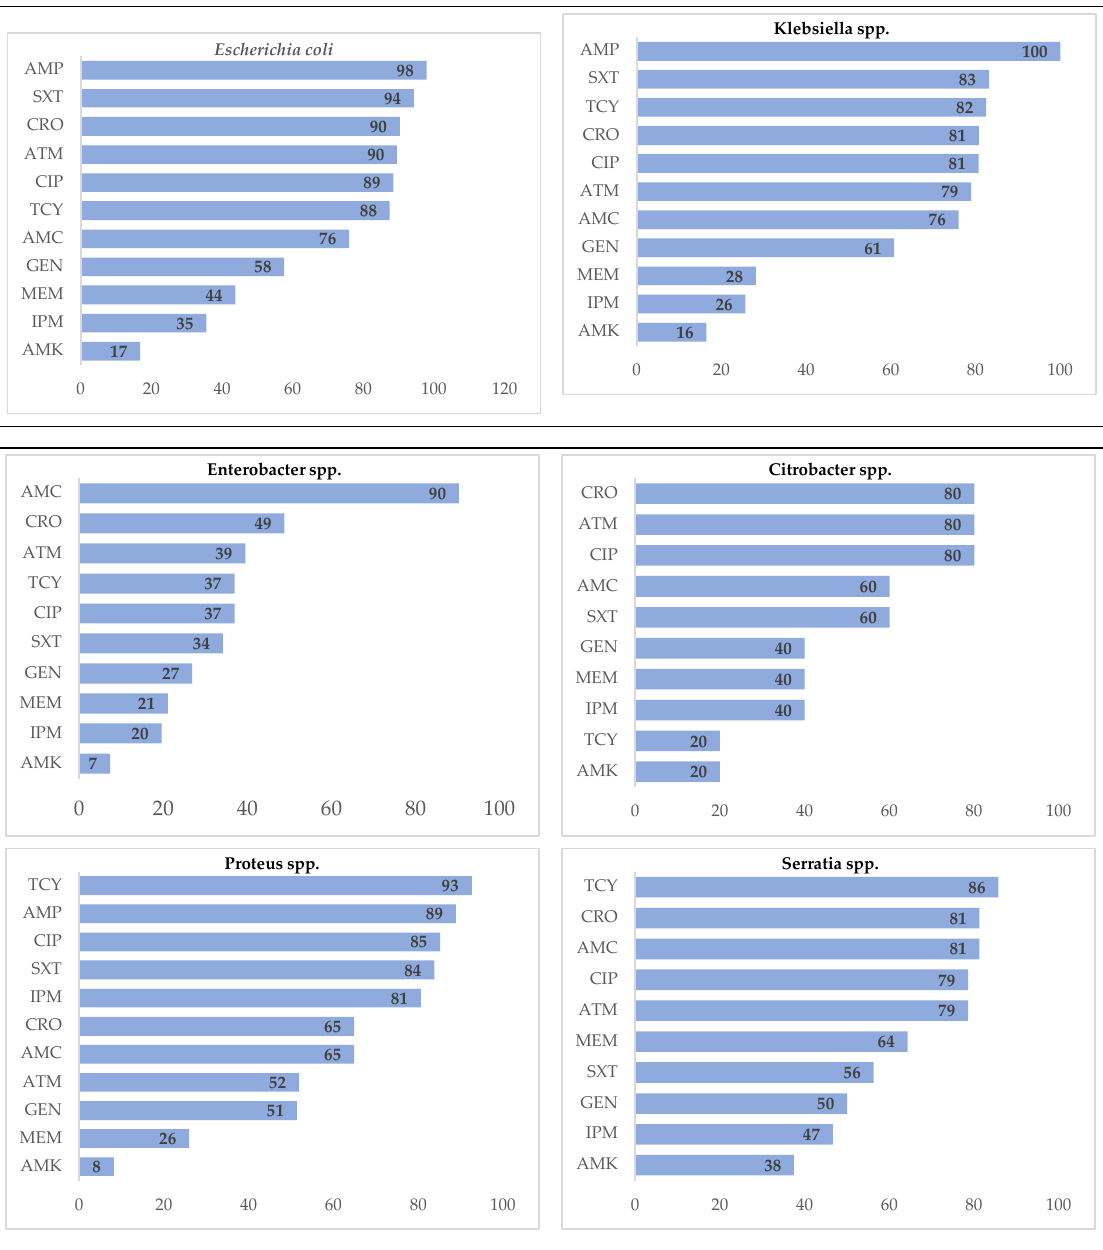
Figure 4. Antimicrobial resistance patterns in Enterobacteriaceae isolates at Yangon General Hospital, Myanmar, in 2018. X-axis represents the percentage of resistance. AMK = Amikacin, AMC = Amoxicillin/Clavulanic acid, AMP = Ampicillin, ATM = Aztreonam, CIP = Ciprofloxacin, CRO = Ceftriaxone, GEN = Gentamicin, IPM = Imipenem, MEM = Meropenem, SXT = Trimethoprim/Sulfamethoxazole, TCY = Tetracycline.